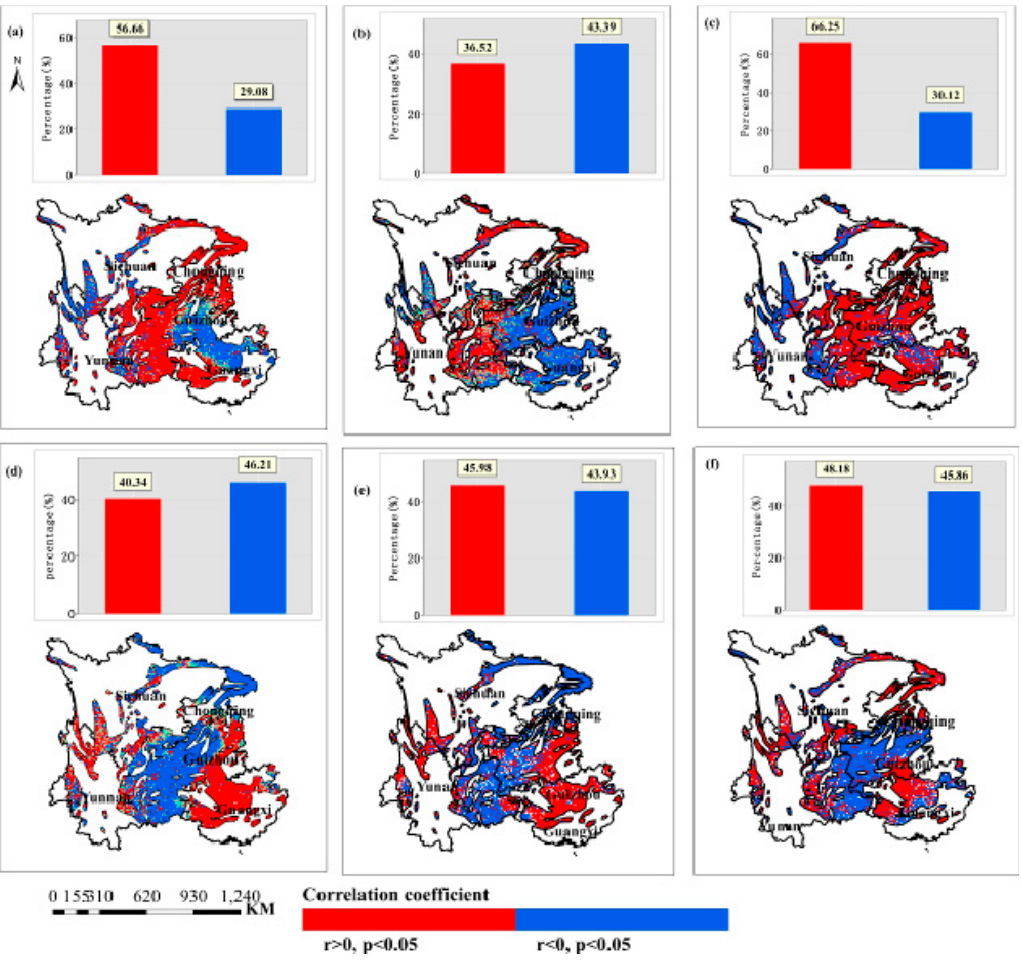
Figure 8. Significant correlation between climate changes and the NDVI over the long-term trend in the karst region of southwest China: ( a ) correlation between temperature and NDVI from 1982–2015, ( b ) before the breakpoint, ( c ) after the breakpoint; ( d ) significant correlation between precipitation and NDVI from 1982–2015, ( e ) before the breakpoint, ( f ) after the breakpoint; (r: correlation coefficient; p: significance level). The insets show the frequency distribution of the corresponding values.